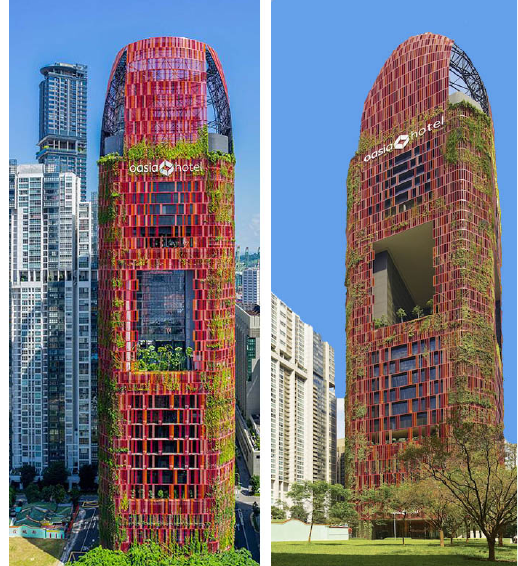
Figure 27. Oasia Hotel Downtown (photograph by